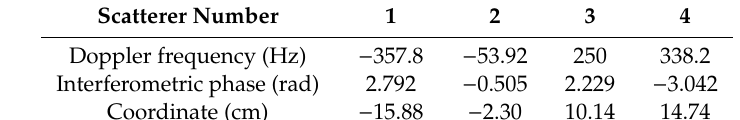
Figure 10. ISAR imaging results of A380 model with small rotation angle. ( a ) Antenna A; ( b ) Antenna B; ( c ) Antenna C.